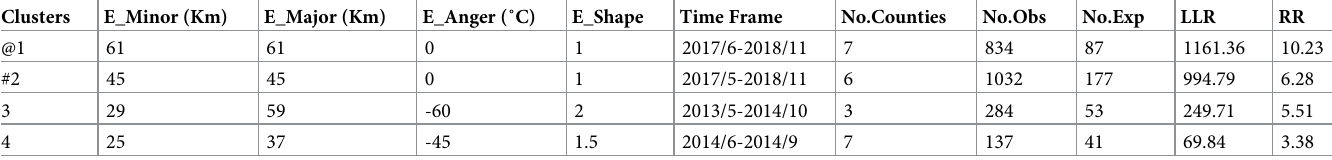
Table 3. Spatiotemporal clusters of scrub typhus detected using Kulldorff’s space-time scan statistic in Fujian, 2012–2020 � . Clusters